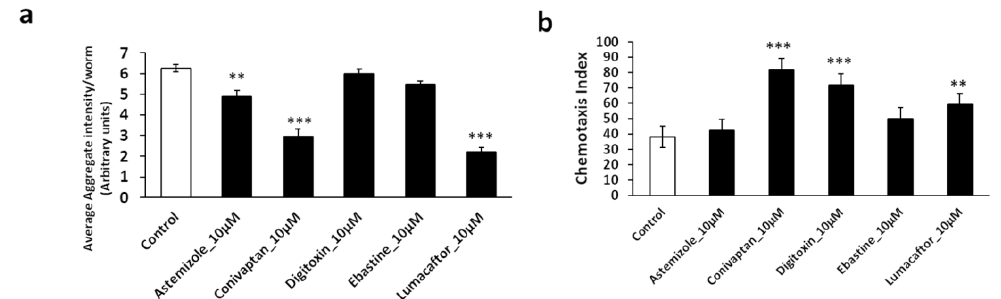
Figure 6 . Drugs targeting the hexokinase::14-3-3 interface reduce aggregation in C. elegans models of human neuropathology. ( a ) Calculated average aggregate counts per worm in C. elegans strain AM141 ( q40::yfp ), a model of HD in which muscle expression of polyglutamine (Q40) fused in-frame to the gene encoding yellow fluorescent protein (YFP) leads to age-dependent accrual of yellow fluorescent aggregates. YFP-positive aggregates were counted in adult worms on day 5 post-hatching; significances were determined by two-tailed t-tests with 13 < N < 18. ( b ) Chemotaxis index of C. elegans strain CL2355, in which uninduced pan-neuronal expression of human A β 1–42 causes age-dependent loss of chemotaxis [15,16], here assessed on day 5 post-hatching. Significances were determined by Fisher exact tests (100 < N < 200): ** p < 0.005; *** p < 0.0005. These drugs were next tested on human neuroblastoma (SH-SY5Y-APP Sw ) cells ex- posed to each drug for 48 h at three concentrations (0.01, 0.1, and 1 μM). Conivaptan at 1 μM reduced amyloid fluorescence per cell by 52% as quantified by thioflavin staining, while lumacaftor achieved a 48% reduction, and digitoxin a 35% reduction, each at 0.1 μM ( Figure 7a – c). We pursued these results by isolating aggregates from SY5Y-APP Sw cells treated with 0.1 μM conivaptan or lumacaftor, which reduced sarkosyl -insoluble and -soluble aggregates 30 – 40% and 35 – 45%, respectively (Figure 7d – f).